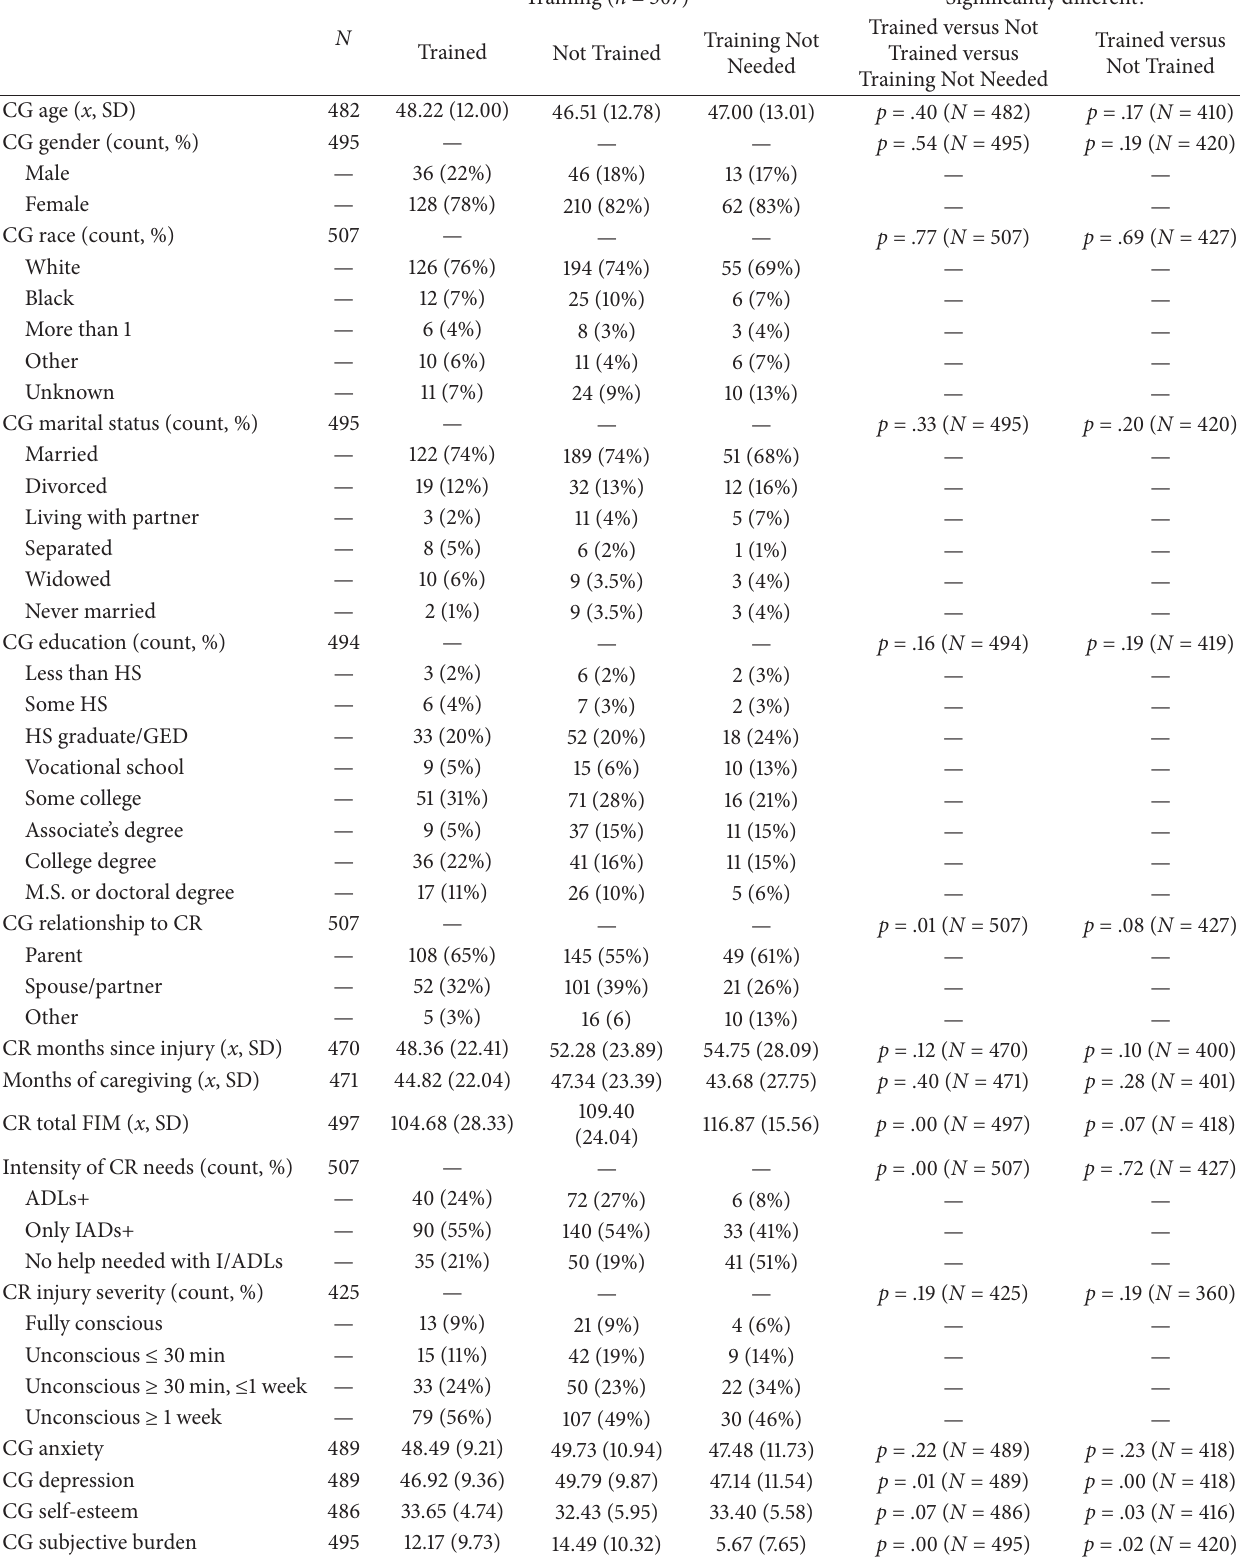
Table2:ComparisonofnavigatingVAorDoDtraininggroupsonsociodemographics,injuryandcaregivercharacteristics,andmentalhealth